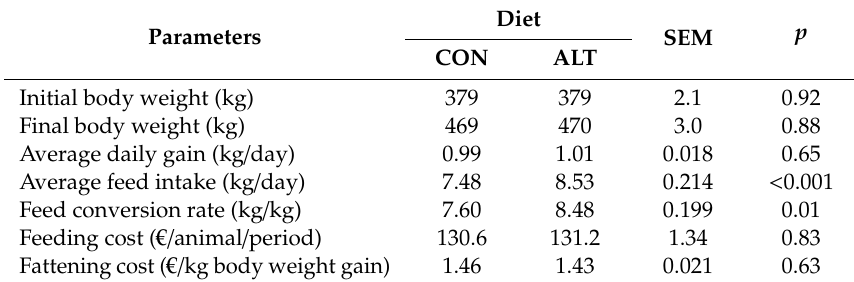
SEM: standard error of the mean.